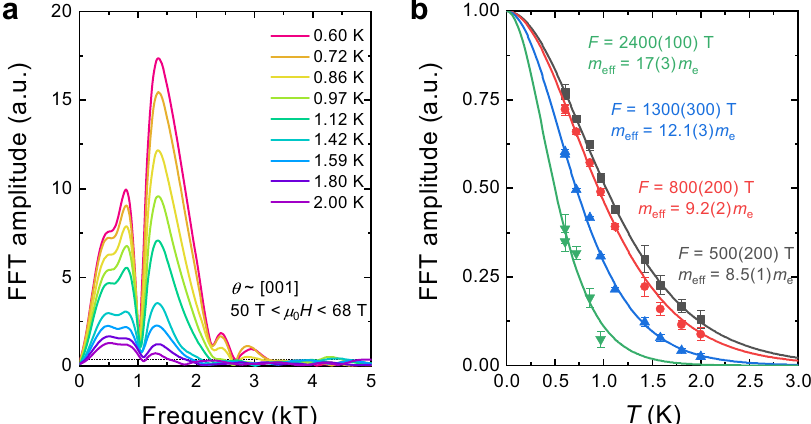
Fig. 2 Rich spectrum of multiple quantum oscillation frequencies in the fi eld-induced metallic phase of YbB 12 . a Fourier transforms of the subtracted quantum oscillations shown in Fig. 1b, for a fi eld window of 50T < μ 0 H < 68T at temperatures between 0.6 and 2.0 K, where the applied fi eld was aligned close to the [001] crystallographic direction. The horizontal dashed line indicates the FFT noise fl oor. Multiple distinct quantum oscillation frequency peaks between 500(200) and at least 3000(200) T are visible. b Quantum oscillation amplitude obtained from the Fourier transform peak height shown in ( a ) as a function of temperature for multiple representative frequencies. Lifshitz – Kosevich temperature dependence fi ts, as shown by the solid lines, yield quasiparticle effective masses m * / m e between 8.5(1) and 17(3) for the various frequencies. A summary of the multiple observed frequencies and their corresponding effective masses is shown in Table bulk volume in the in fi nite fi eld limit, and the observation that more torque and contacted electrical transport 4 . Figure 2a shows the insulating samples exhibit larger amplitude quantum oscillations, quantum oscillation frequency spectrum in the fi eld-induced have been shown to be intrinsic to the insulating bulk of YbB 124 . metallic phase, comprising multiple frequencies extending up to at least 3000(200) T. We note that even higher frequencies may Curiously, these multiple frequencies were missed in other reports exist, especially in view of the high value of linear speci fi c heat γ ≈ of a single quantum oscillation frequency in the insulating phase of 67 mJ mol − 1 K − 2 measured in the fi eld-induced metallic regime of YbB 125 . Such a quantum oscillation spectrum comprising multiple YbB 1210 . Multiple comparable quantum oscillation frequencies frequencies is expected from numerical Fermi surface simulations of between ~300 and 800 T are measured in both the metallic and metallic YbB 12 involving hybridised f -electrons 4 . In these theoretical insulating phases (Table 1); the multiple frequencies measured by simulations of the Fermi surface, multiple Fermi surface pockets magnetic torque in the insulating phase of YbB 12 had previously located away from the centre of the Brillouin zone would be expected to yield a series of frequency branches; multiple been reported, which, through a comparison of the absolute frequencies would further be expected from a multiplicity of amplitude of quantum oscillations with the expectation from the